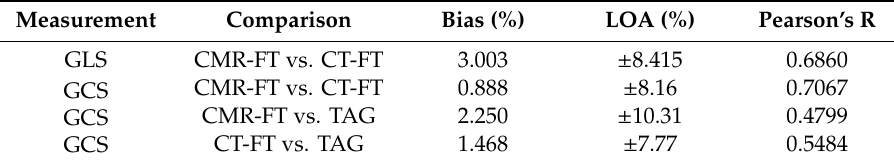
Figure 5. Bland–Altman analysis of the ( a ) GLS assessment between CT-FT and MR-FT; ( b ) GCS assessment between CT-FT and MR-FT; ( c ) GCS assessment between MR-FT and TAG; and ( d ) GCS assessment between CT-FT and TAG. Abbreviations: MR-FT: magnetic resonance feature tracking; CT-FT: computed tomography feature tracking; TAG: myocardial tagging; GLS: global longitudinal strain; GCS: global circumferential strain. Table 4. Tabular representation of Bland–Altman and Pearson’s correlation analyses for strain